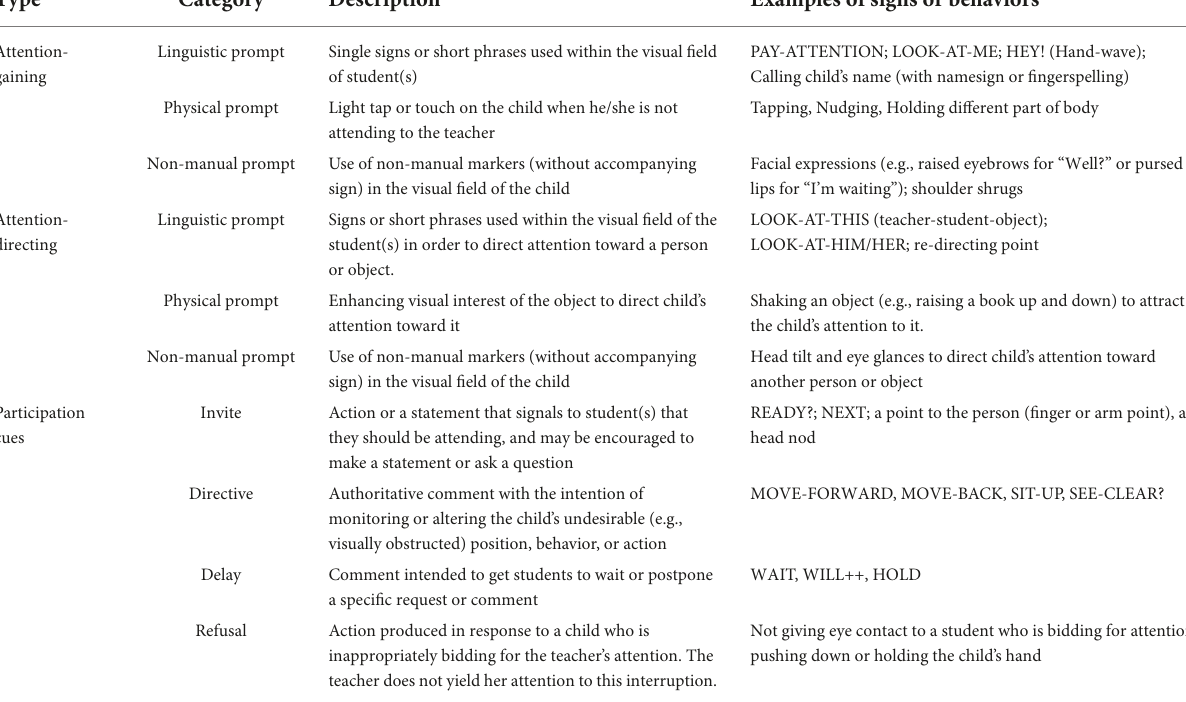
NEXT! TABLE 4 Coding category descriptions: Teacher’s visual engagement